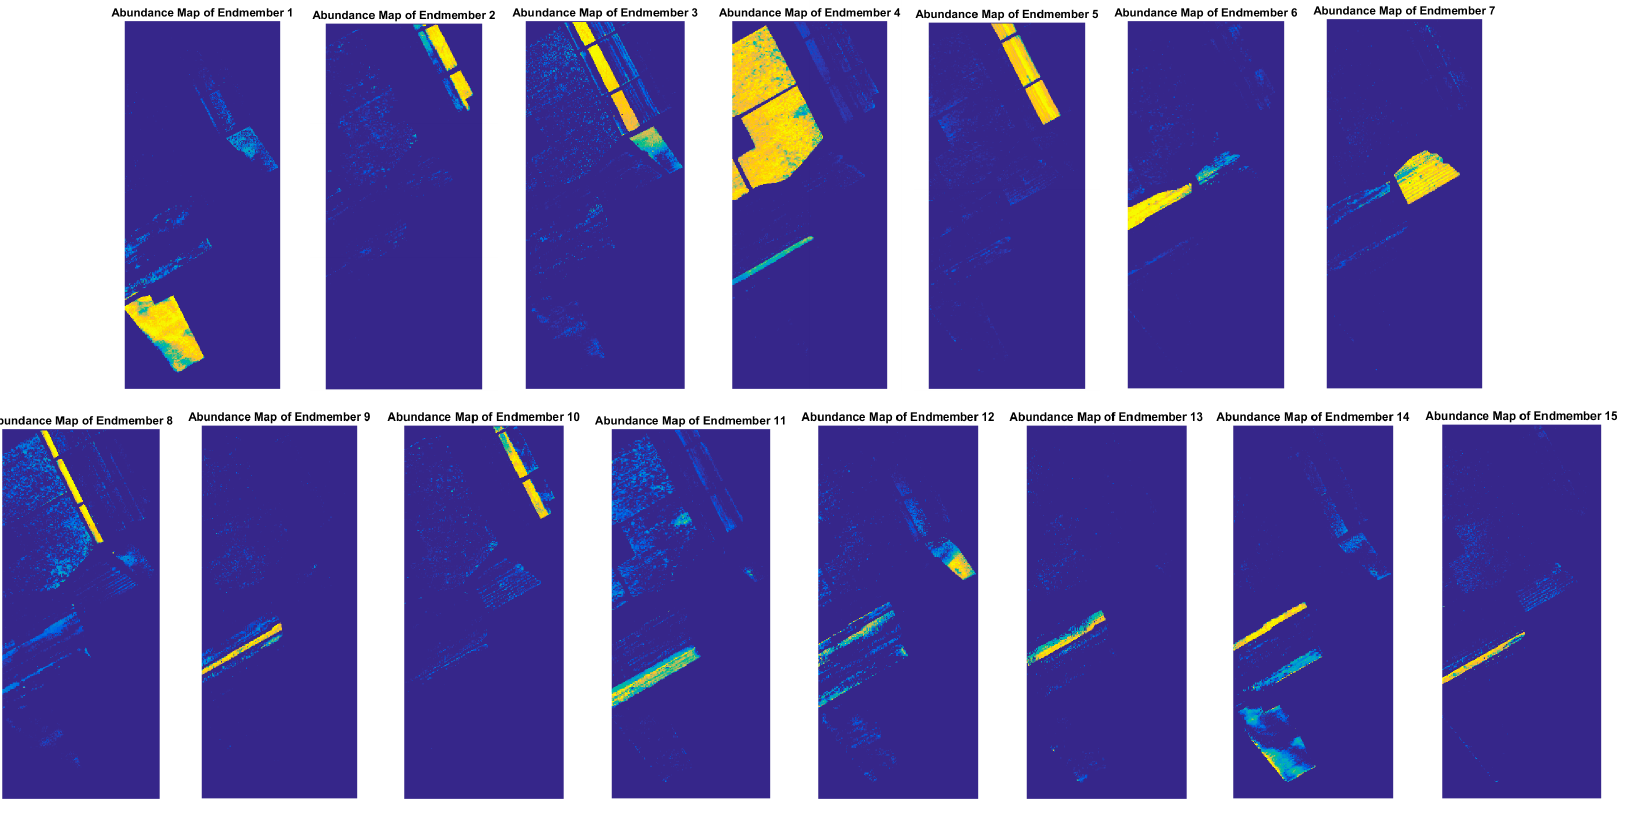
Figure 20. The fractional abundances estimated from the Salinas area using the FCLS method and the selected bands by the proposed ISI-PS algorithm in the unsupervised approach.